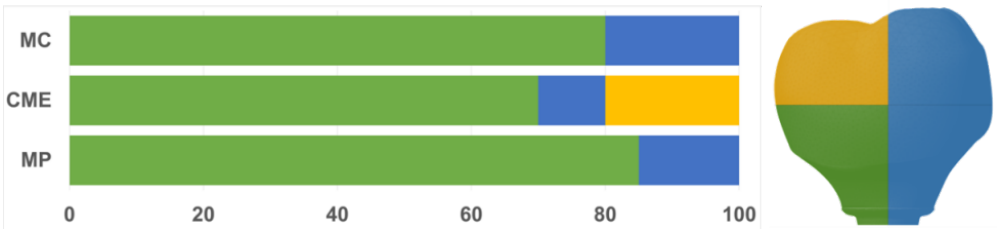
Figure 8. Quantitative analysis of the failures in % regarding the groups and the fracture location. In green, cracks found in the cervical region of the crown. In yellow, cracks found in the occlusal region. In blue, catastrophic failure.